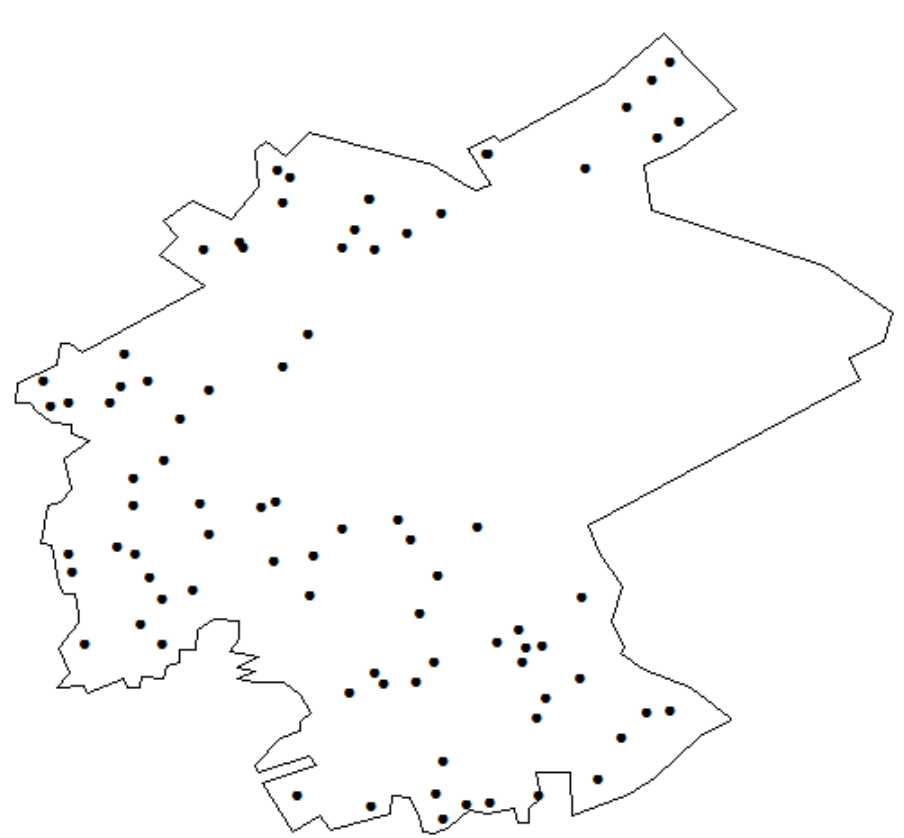
Figure 2. Soil sampling